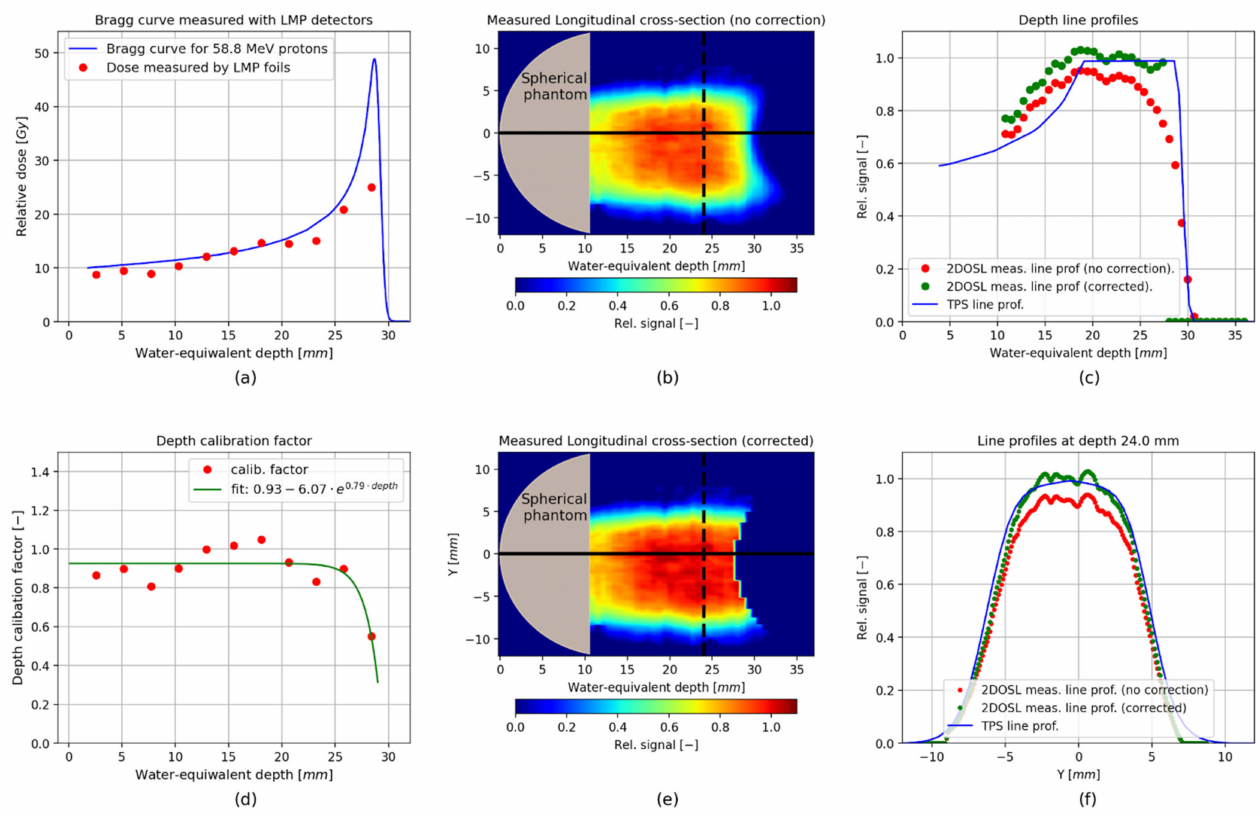
Figure 14. ( a ) Depth dose correction using results of dose measurements with 2D LMP foils of a monoenergetic proton beam, measured with a Markus ionization chamber, along with the corresponding measurements with 2D LMP foils (data according to the [18]); ( b ) Uncorrected longitudinal cross-section through the image centre; ( c ) Comparison of longitudinal line profiles through the image centre; ( d ) Depth correction factor calculated as the ratio of the relative dose measured by the Markus chamber and the 2D LMP foils; ( e ) Longitudinal cross-section through the centre of the corrected 3D image ( f ) Line profiles along Y axis for 3D dose calculated in TPS and 3D uncorrected and corrected images measured with the stack of 2D LMP